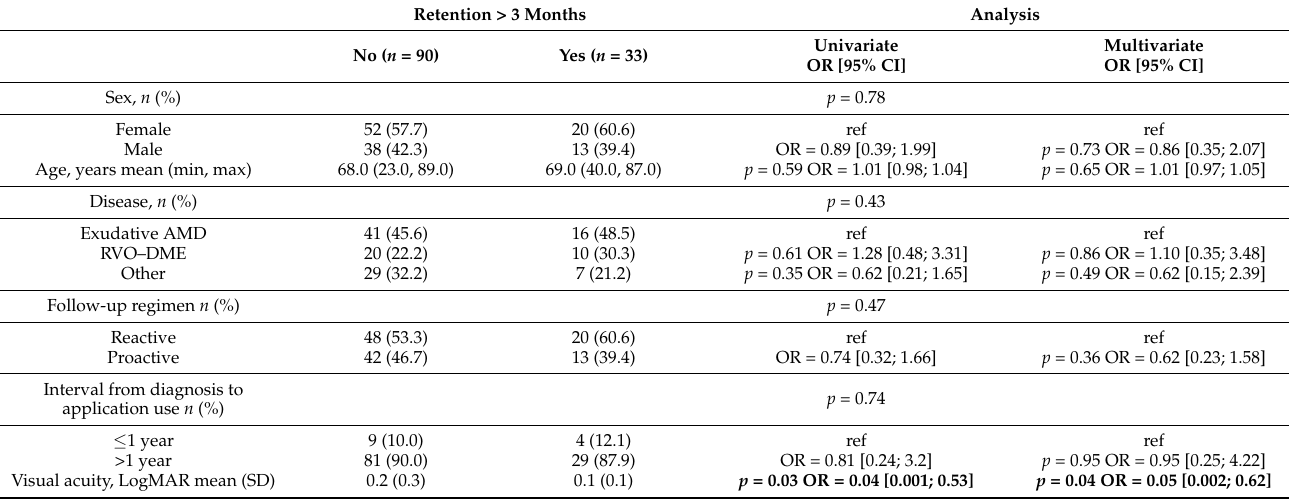
Table 4. Factors associated with retention > 3